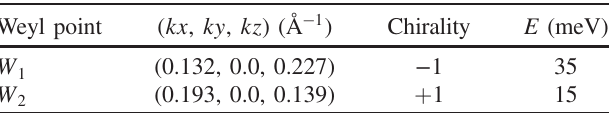
TABLE I. The positions ( kx , ky , kz ) in k space of the two nonequivalent Weyl points in the BZ. The other seven pairs of Weyl points are related to the ones listed with reflections located at ( kx , ky , − kz ) and ( − kx , ky , (cid:2) kz ) with the same energy and chirality as ( kx , ky , kz ), and ( ky , (cid:2) kx , (cid:2) kz ) with the same energy but opposite chirality relative to ( kx , ky , kz ). Fermi energy is set to 0 eV.